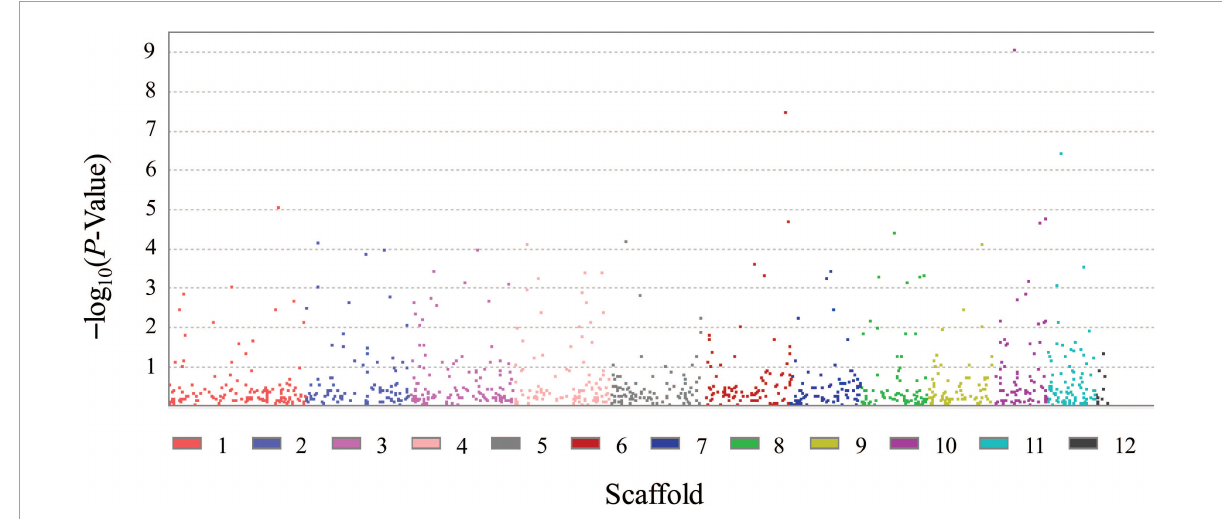
FIGURE4 Genomic polymorphisms associated with FB1 production amongst 67 strains of Fusarium proliferatum